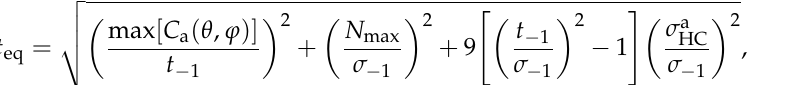
Figure 8. Experimental and predicted results for carbon structural steel SM45C.